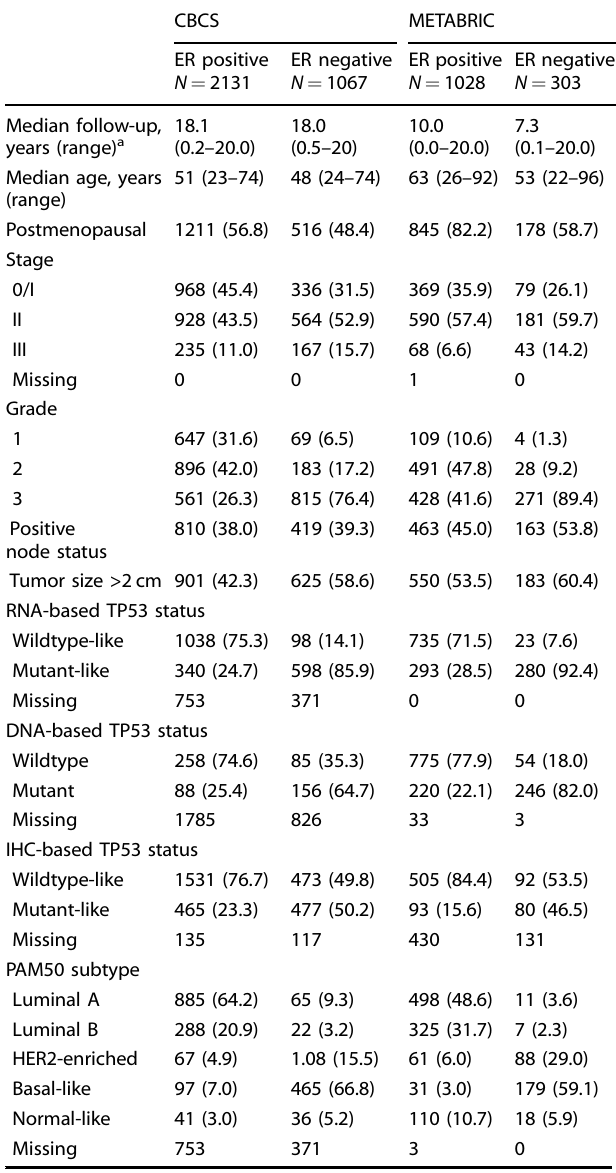
Table 1. Patient and clinical characteristics, strati fi ed by estrogen receptor (ER)